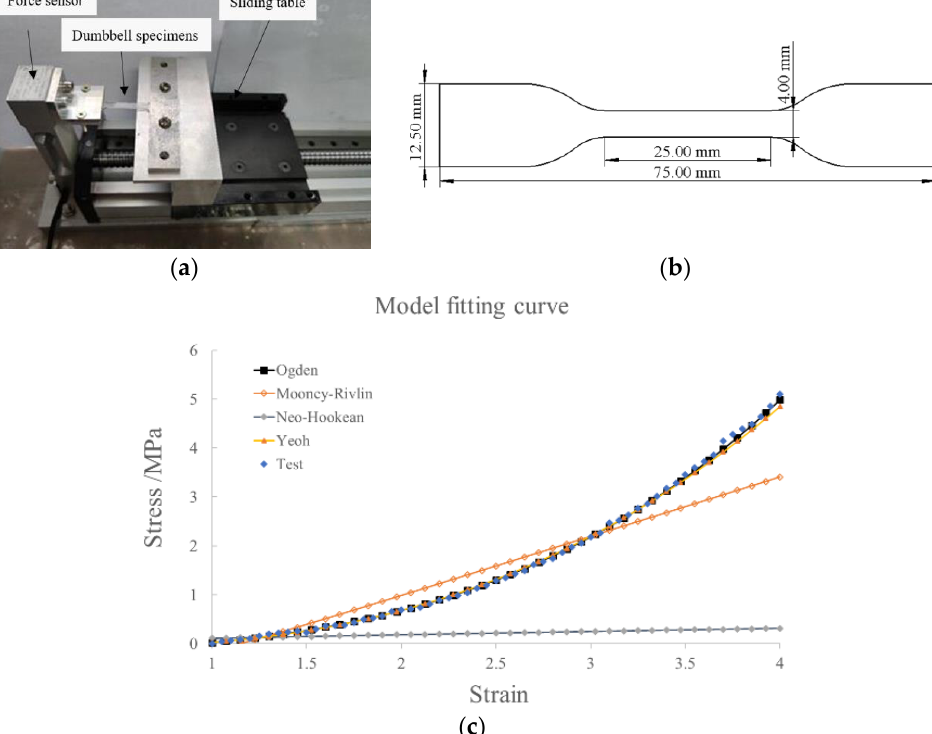
Figure 3. ( a ) A uniaxial tensile test was performed; ( b ) the averaged nominal stress–strain curve of silicone rubber and model fitting curve; ( c ) size information of the dumbbell-shaped specimens.